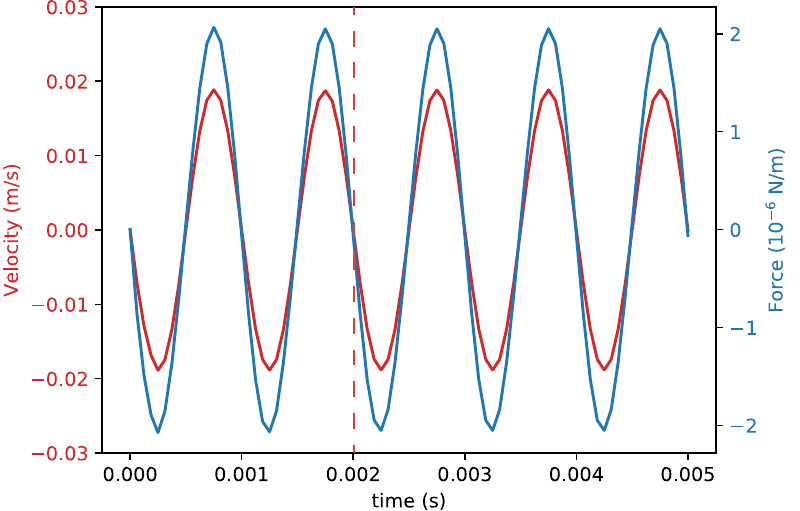
Figure 7. Velocity and simulated drag force as a function of time in the first 0.005s. The data at the right hand side of the red dashed line was used for calculating β 1